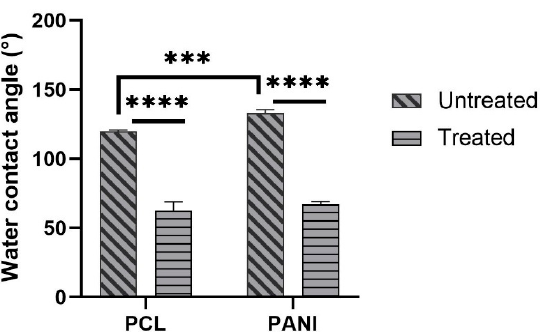
Figure 7. Water contact angle measures of PCL and PANI electrospun membranes before and after plasma treatment. Statistical difference (*** p < 0.001; **** p < 0.0001). The decrease in the water contact angle for treated PCL and PCL-PANI to 62.7° ± 6.3° and 67.1° ± 2° demonstrated the effective modification of the surface after plasma treat- ment.